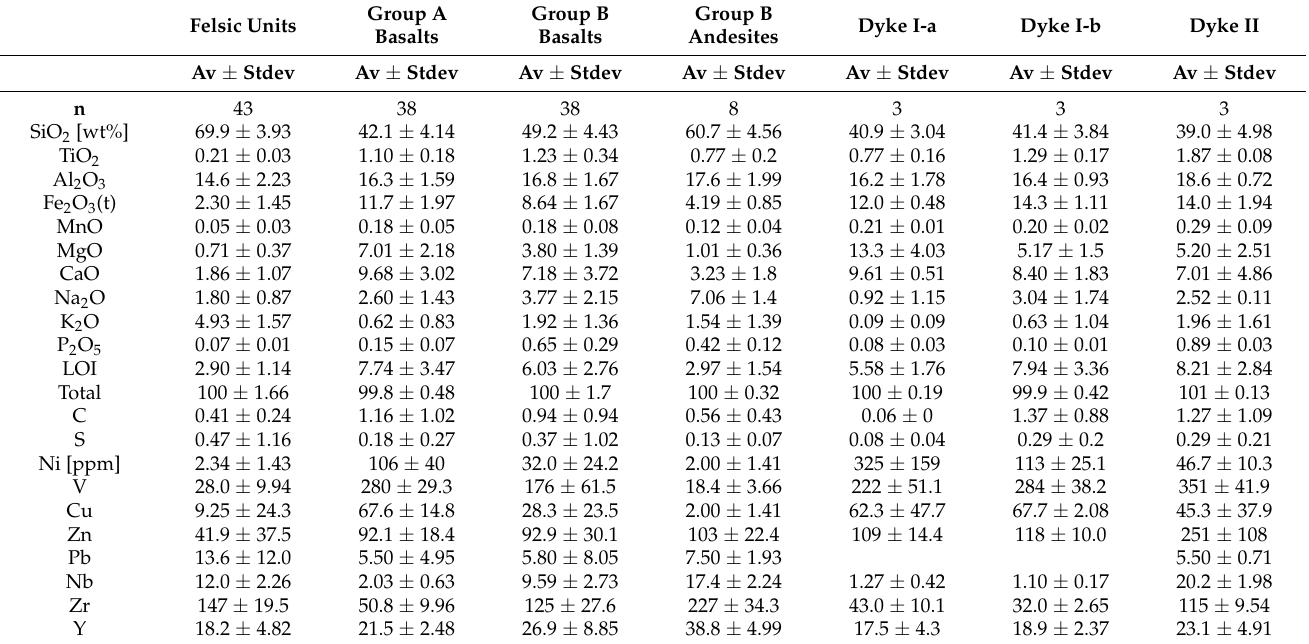
Table 2. Summary of whole rock lithogeochemistry for selected elements and parameters of the igneous units at the A6 Anomaly. Abbreviations: Av ± Stdev—average ± standard deviation, n—number of